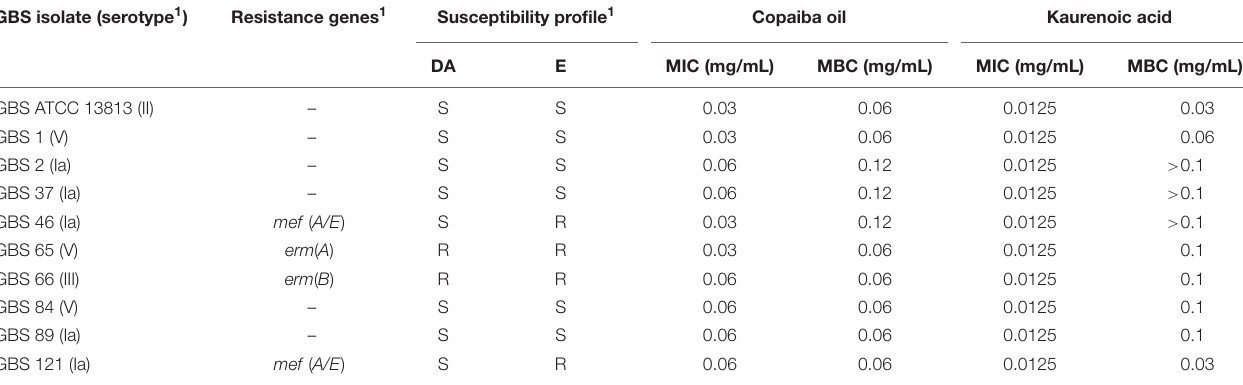
TABLE 1 | Streptococcus agalactiae susceptibility profile and antibacterial activity of copaiba oil and kaurenoic acid. GBS isolate (serotype 1